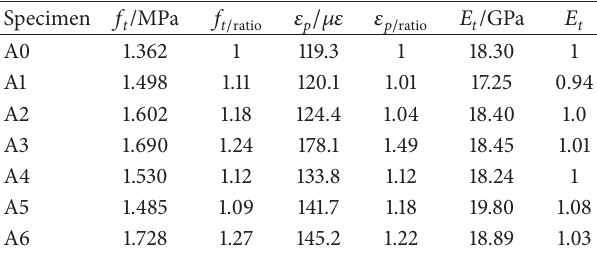
Table 3: The axis-tensile test results for multiscale polypropylene fiber